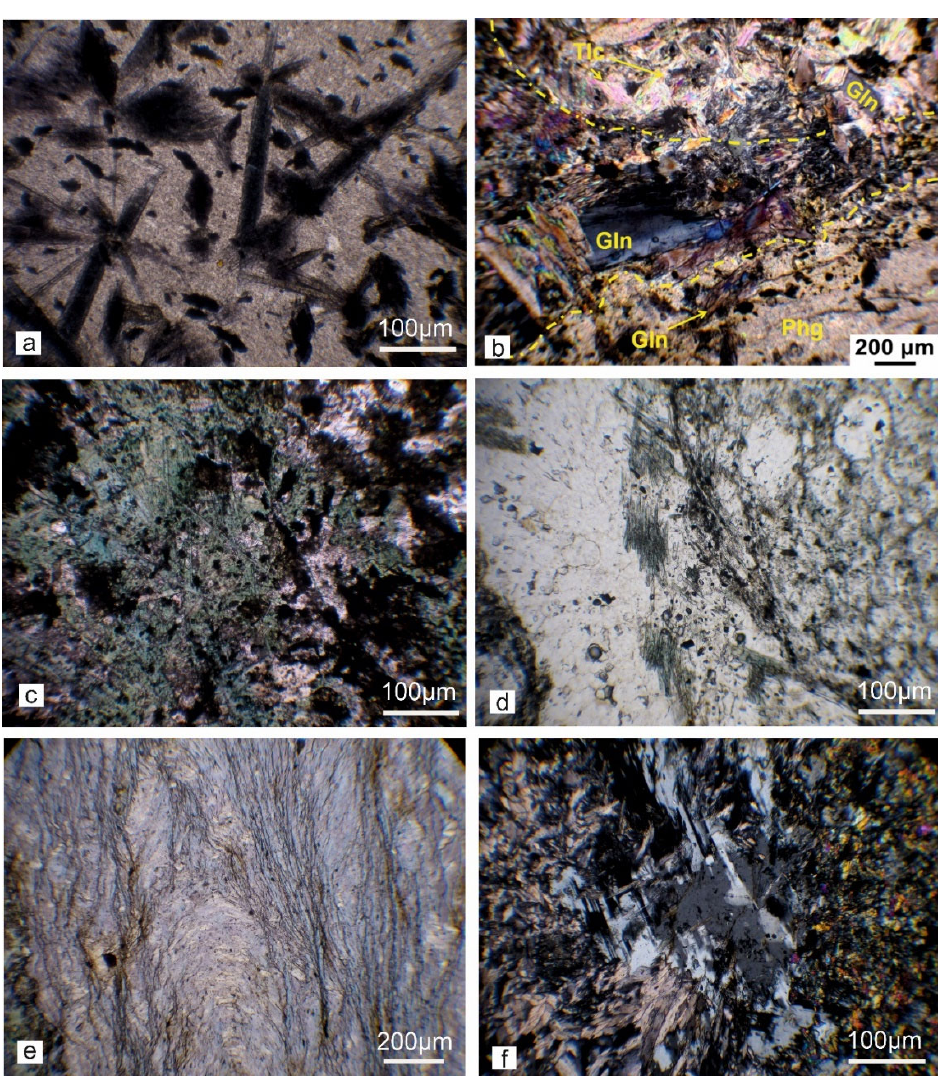
Figure 9. Microstructures of Meliatic metabasalts. ( a ) Gln ‐ Phg ‐ rich blueschist (s. DOL ‐ 1) of calc ‐ alkaline basalt protolith. ( b ) Contact of blueschist (s. DOL ‐ 1) with Tlc ‐ Phg ‐ Chl ‐ Cal schist. ( c ) N ‐ MOR metabasalt (s. DO ‐ K1) with metamorphic Act (needles) to Mg ‐ Rbk (bluish blasts), Chl, Ep and albitized Pl laths. ( d ) Metamorphic veinlets crosscutting radiolarians ‐ bearing metachert (s. DO ‐ K2, K3) with blue ‐ green Amp ‐ Cal ‐ Chl ‐ Ep aggregates. ( e ) N ‐ MORB type blueschist (s. MR ‐ 1) from below the Malý Radzim Hill at Brdárka. The first and secondary metamorphic cleavage planes are defined by blue Gln. ( f ) Blueschist of N ‐ MORB (s. MR ‐ 1) with layers rich in Ep, Ab, and Gln.